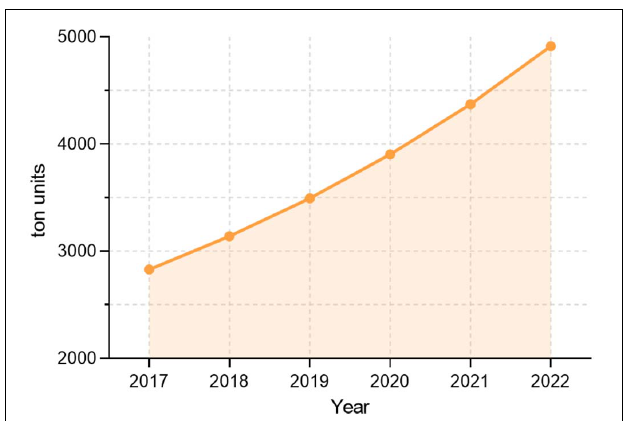
FIGURE 2 | Growth in international consumption of iron-oxide nanoparticles over the years of 2017–2022. Data from Nano-Powder Factory